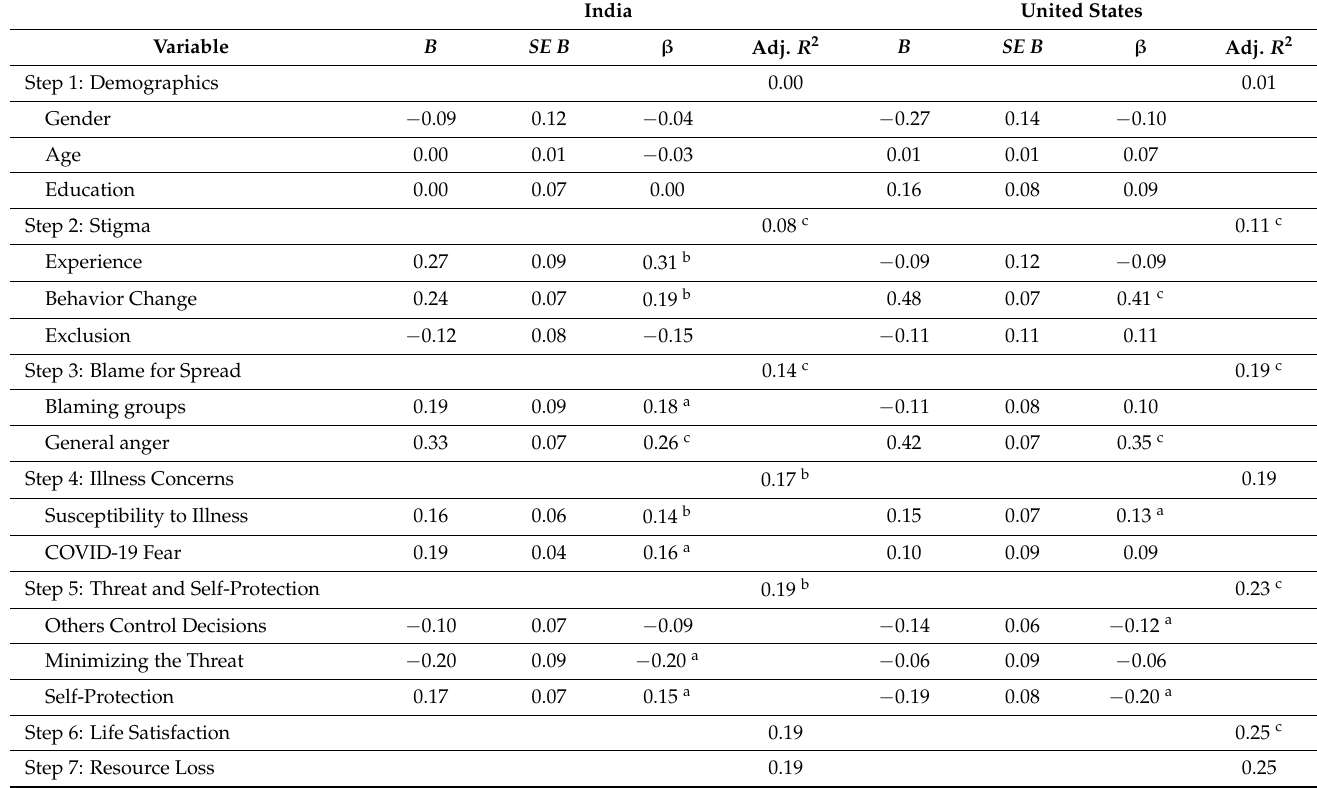
Table 2. Predicting vaccine intent in India and the United States.